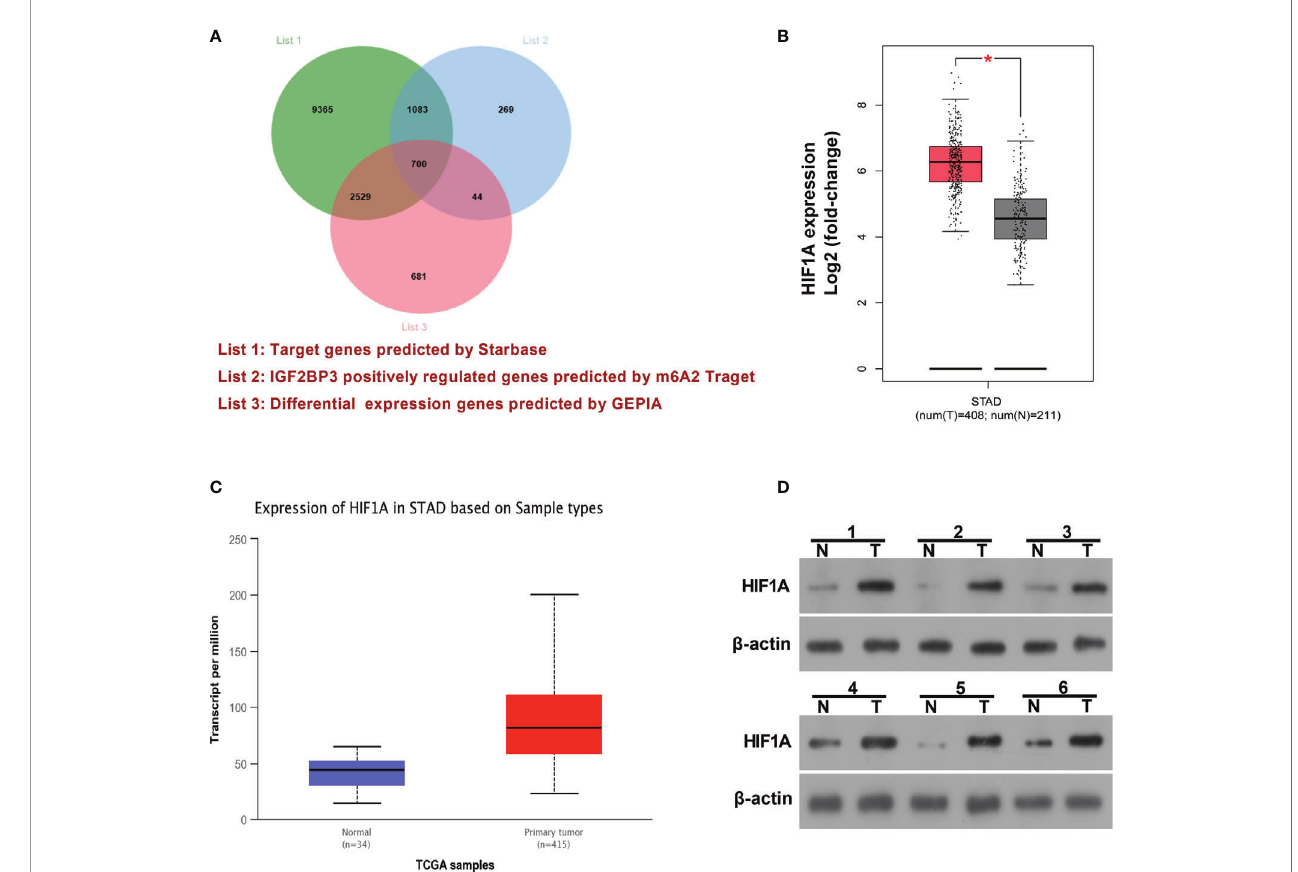
FIGURE 3 | HIF1A as a potential IGF2BP3 target was highly expressed in SC. (A) Venn analysis (http://jvenn.toulouse.inra.fr/app/example.html) for genes in Supplementary Tables 1 , 2 , and 3 . List 1: Starbase-predicted mRNAs that could bind with IGF2BP3. List 2: m6A2Target-analyzed genes that could be positively regulated by IGF2BP3. List 3: GEPIA-analyzed differentially expressed genes in SC tissues versus normal tissues. (B) Expression analysis of HIF1A in 408 cases of SC tumor samples and 211 cases of normal samples by the GEPIA website (http://gepia.cancer-pku.cn/). (C) Expression analysis of HIF1A in primary SC tumor tissues (n=415) and normal tissues (n=34) by the UALCAN database (http://ualcan.path.uab.edu/). (D) Expression level of HIF1A in 6 pairs of SC tumor tissues and adjacent normal tissues was determined by western blot assay. * p <